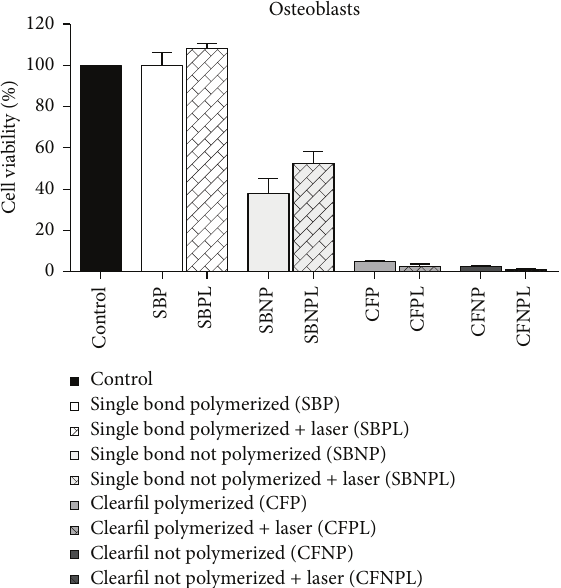
Figure 4: Graphic representation of the cell viabilities of osteoblast- like cells in response to the substances leached from the dental adhesives: Adper Single Bond 2 and Clearfil SE Bond, whether or not polymerized, followed by LPT or not. There are no differences between irradiated and nonirradiated cells submitted to the same adhesive system.